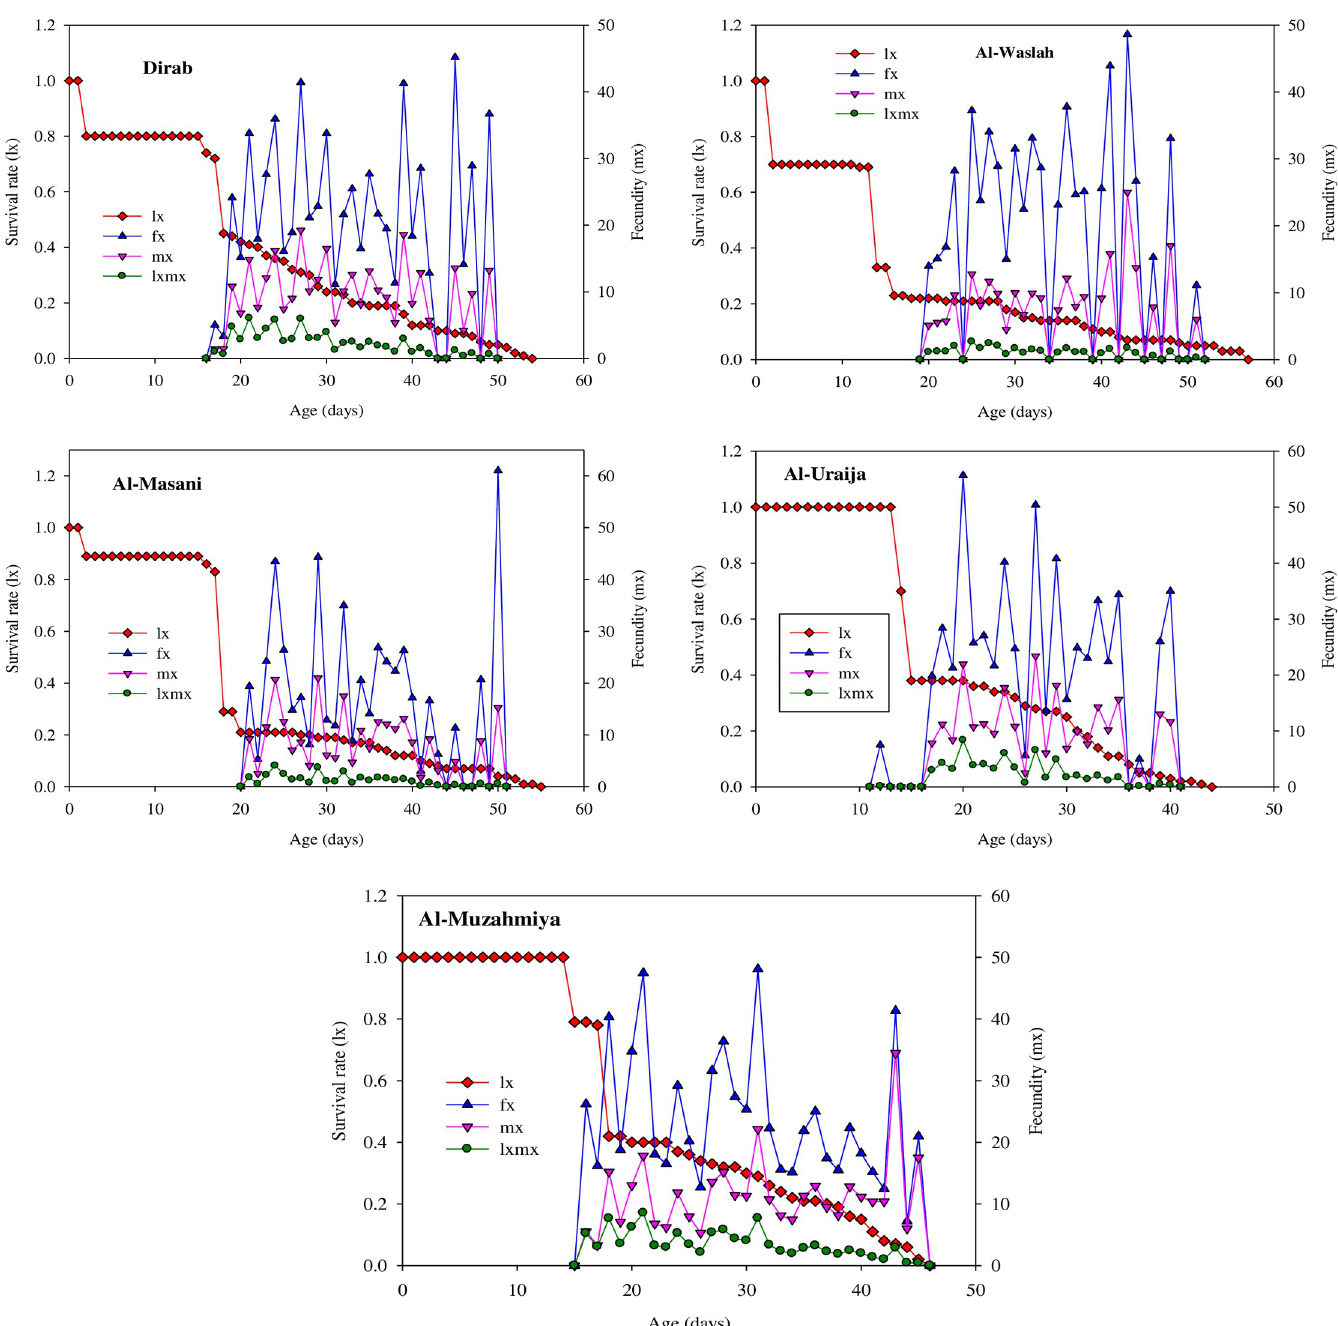
Fig 2. Age-specific survivorship (l x ), age-specific female fecundity (f x ), age-specific fecundity of the total population (m x ), and age-specific maternity (l x m x ) for the Dirab, Al-Masanie, Al-Washlah, Al-Uraija, and Al-Muzahmiya populations of house fly.